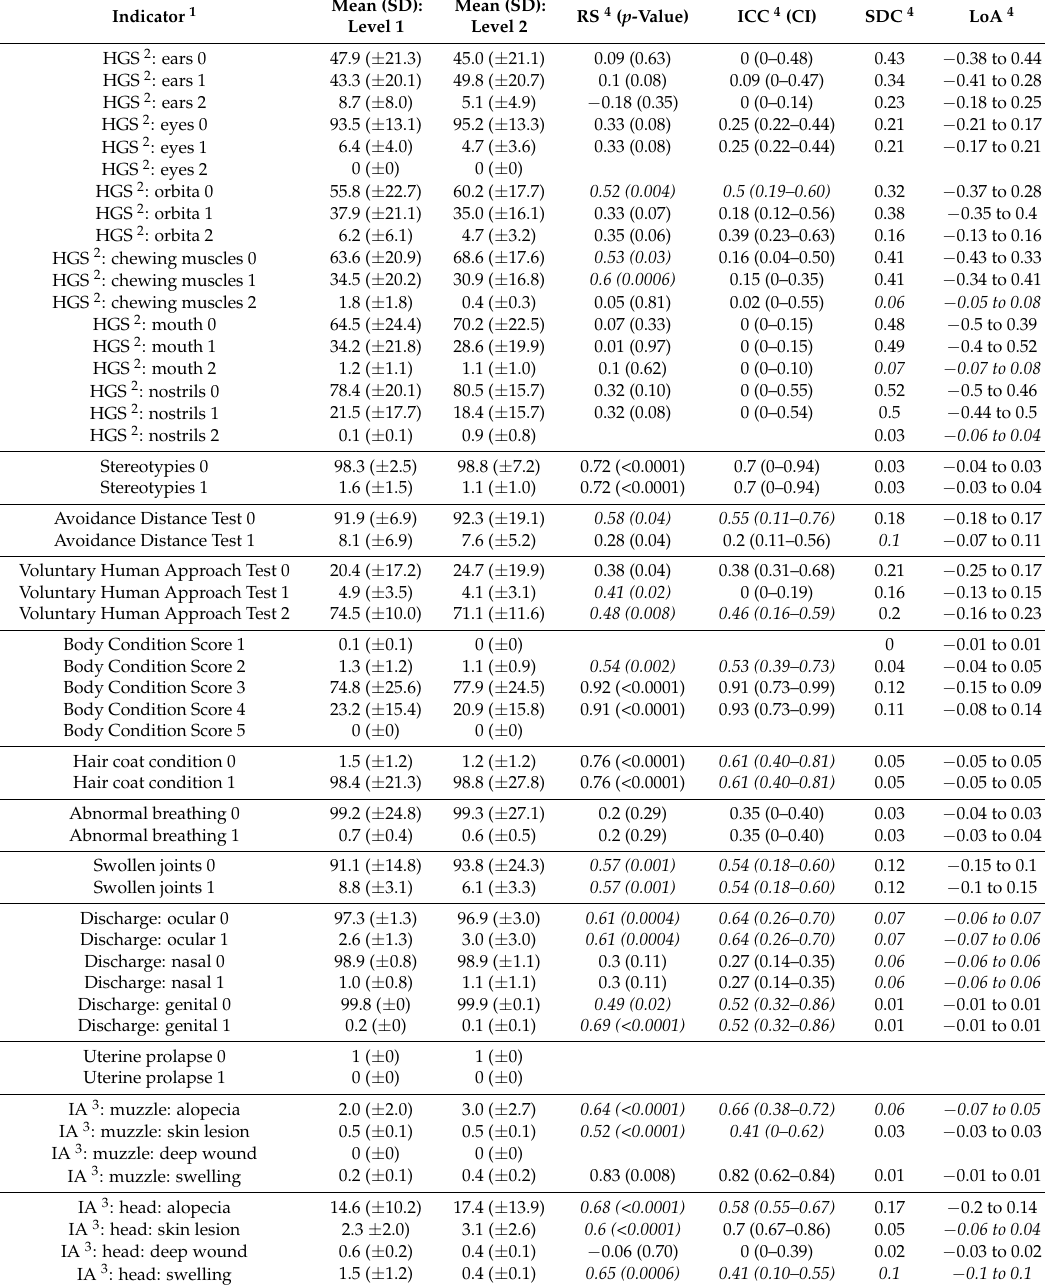
Table 2. Mean values (and standard deviations (SD)) of the percentages of affected animals for each animal-based indicator used in the first (level 1) and second level (level 2) as well as the calculated statistical parameters Spearman’s Rank Correlation Coefficient (RS) (and p -values), Intraclass Correlation Coefficient (ICC) (and confidence intervals (CI)), Smallest Detectable Change (SDC) and Limits of Agreement (LoA) for the comparison of the two levels. The typing style indicates poor (normal), acceptable ( italic ) and good agreement ( bold